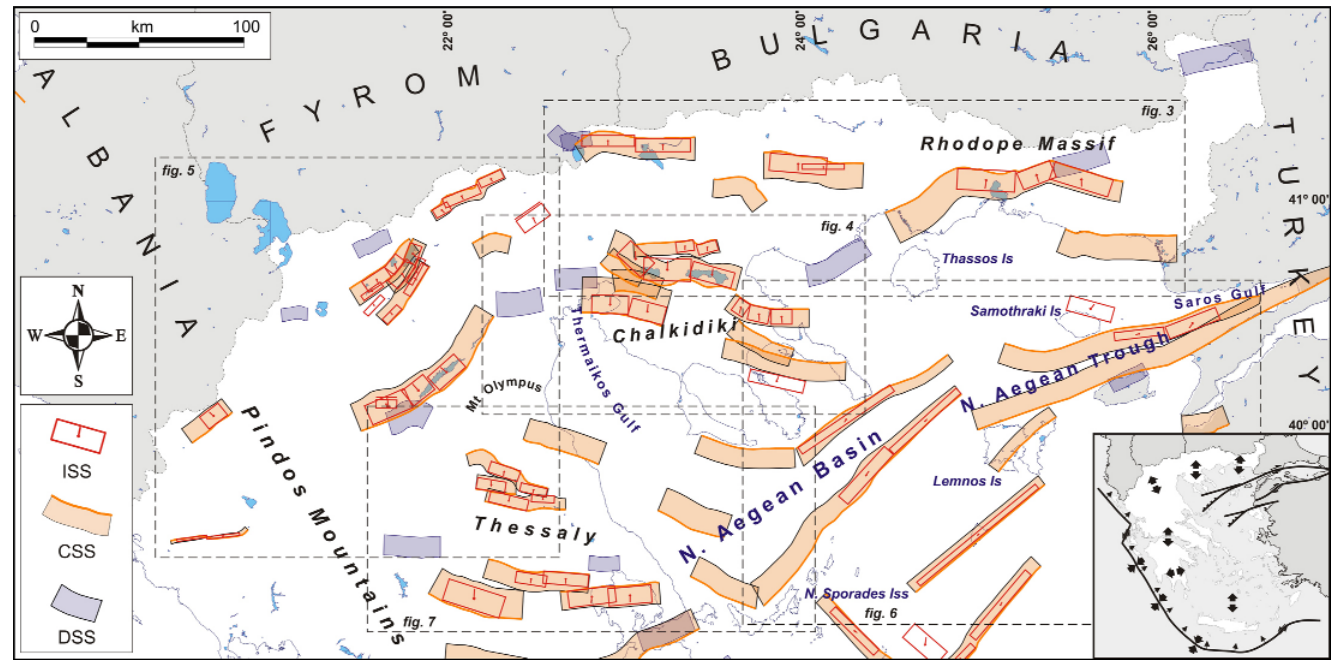
Figure 1. Map of the seismogenic sources recognized in the Northern Aegean region and included to date in the GreDaSS. Inset: Overview of the region. Dashed boxes indicate Figures for further details. ISS, individual seismogenic sources; CSS, composite seismogenic sources; DSS, debated seismogenic